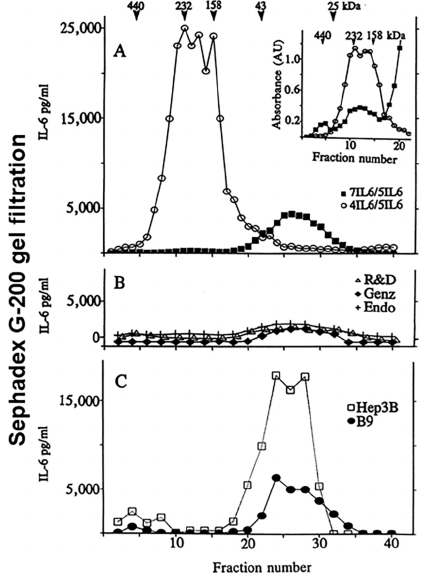
Figure 6. Distinct classes of chaperoned IL-6 in human blood–differential immunological and bio- logical availability. Sephadex G-200 gel filtration and immunologic and biologic characterization of IL-6 complexes in serum from a melanoma patient who was first actively immunized using the received mAb-KLH+BCG regimen and then using an autologous anti-cancer antigen preparation (as in [24,67]). One ml of serum was fractionated by gel filtration and the eluate fractions were assayed for IL-6 in five different ELISAs and two bioassays. Panel A, IL-6 concentrations assayed in the 7IL6/5IL6 (▪) and 4IL6/5IL6 (o ◌ ) ELISAs. The inset illustrates the absorbance values recorded in each of these two ELISAs using the indicated elution fractions. Panel B, IL-6 concentrations assayed using three different commercial kits and expressed in terms of the kit standards: R&D (Δ), Genzyme ( ♦ ), and Endogen (+). Panel C. IL-6 concentrations assayed using the B9 hybridoma proliferation (●) or the hepatocyte Hep3B stimulation bioassays (□). Adapted from Ndubuisi et al., 1998 [70].